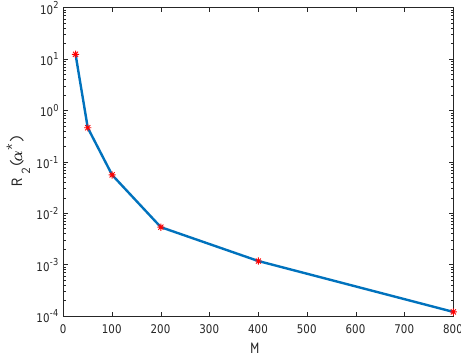
Figure 2. The graph of the variety of R 2 ( α ∗ ) with M .